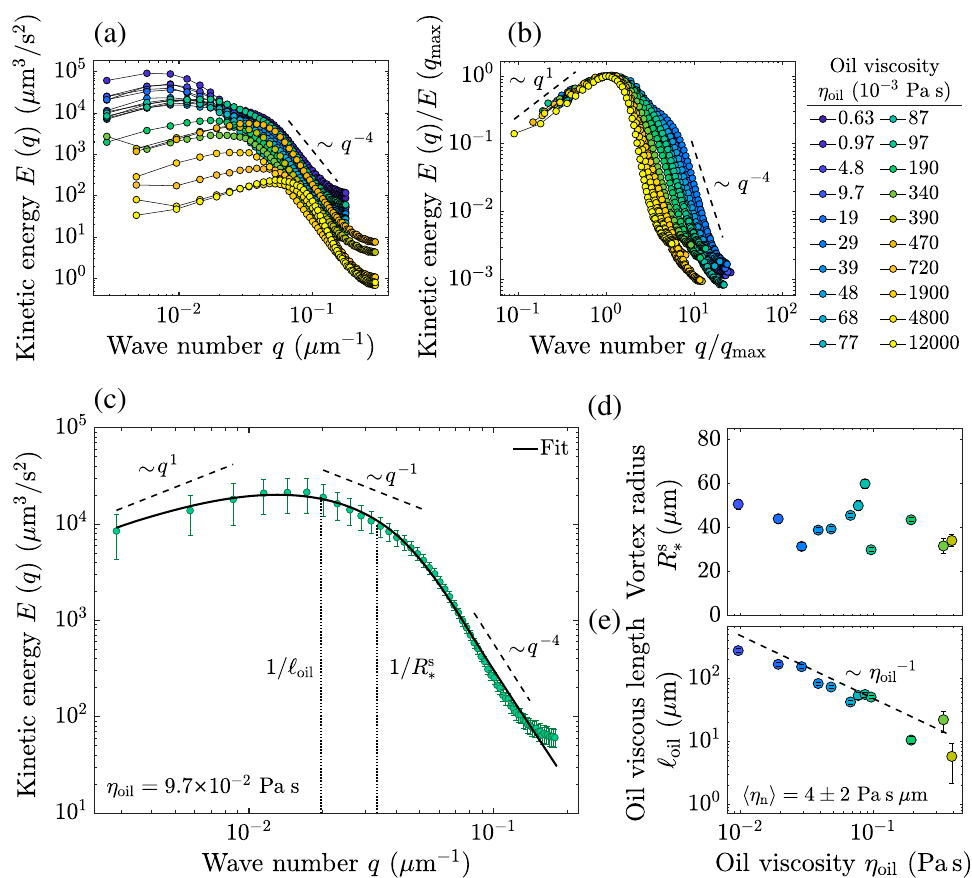
FIG. 3. Oil viscosity tunes the scaling regimes of active nematic turbulence. (a) Kinetic energy spectra of turbulent flows in an active nematic film in contact with a layer of oil, for 20 different oil viscosities. The data are averaged over 500 frames. (b) Rescaling each spectrum by its maximum and its corresponding wave number clearly showcases the large-scale scaling regime. (c) Fit of Eq. (1) to a representative spectrum at intermediate oil viscosity (see fits for all oil viscosities in Fig. S1 in Supplemental Material [52]). As predicted by our theory (see Fig. 2), the spectrum features signatures of three scaling regimes, separated by two crossover lengths: the mean vortex ¼ η = η size R s (cid:2) and the viscous length l (vertical dashed lines). Averages are over 500 frames. Error bars are standard deviations. n oil oil (d),(e) Mean vortex radius (d) and oil viscous length (e) obtained from the spectral fits in the range of intermediate oil viscosities in which the theory fits the data well. Error bars are standard errors of the mean. The mean nematic viscosity obtained from these fits is indicated in (e) as an inset (see also Fig. S2